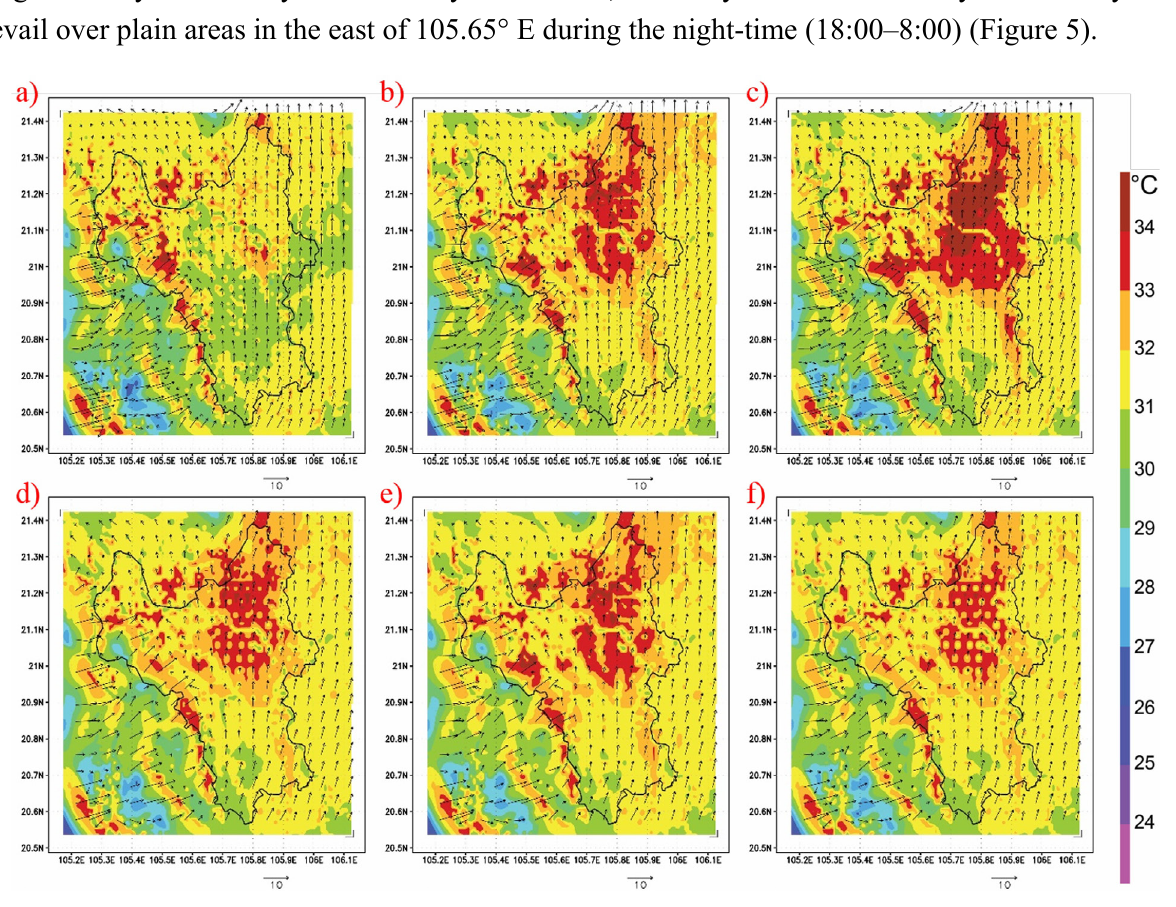
Figure 5. Air temperature and wind distribution at 1:00 on 17 June for ( a ) U_CUR; ( b ) U_HMP; ( c ) U_NOGREEN; ( d ) U_PARK; ( e ) U_HMPFOREST; ( f )